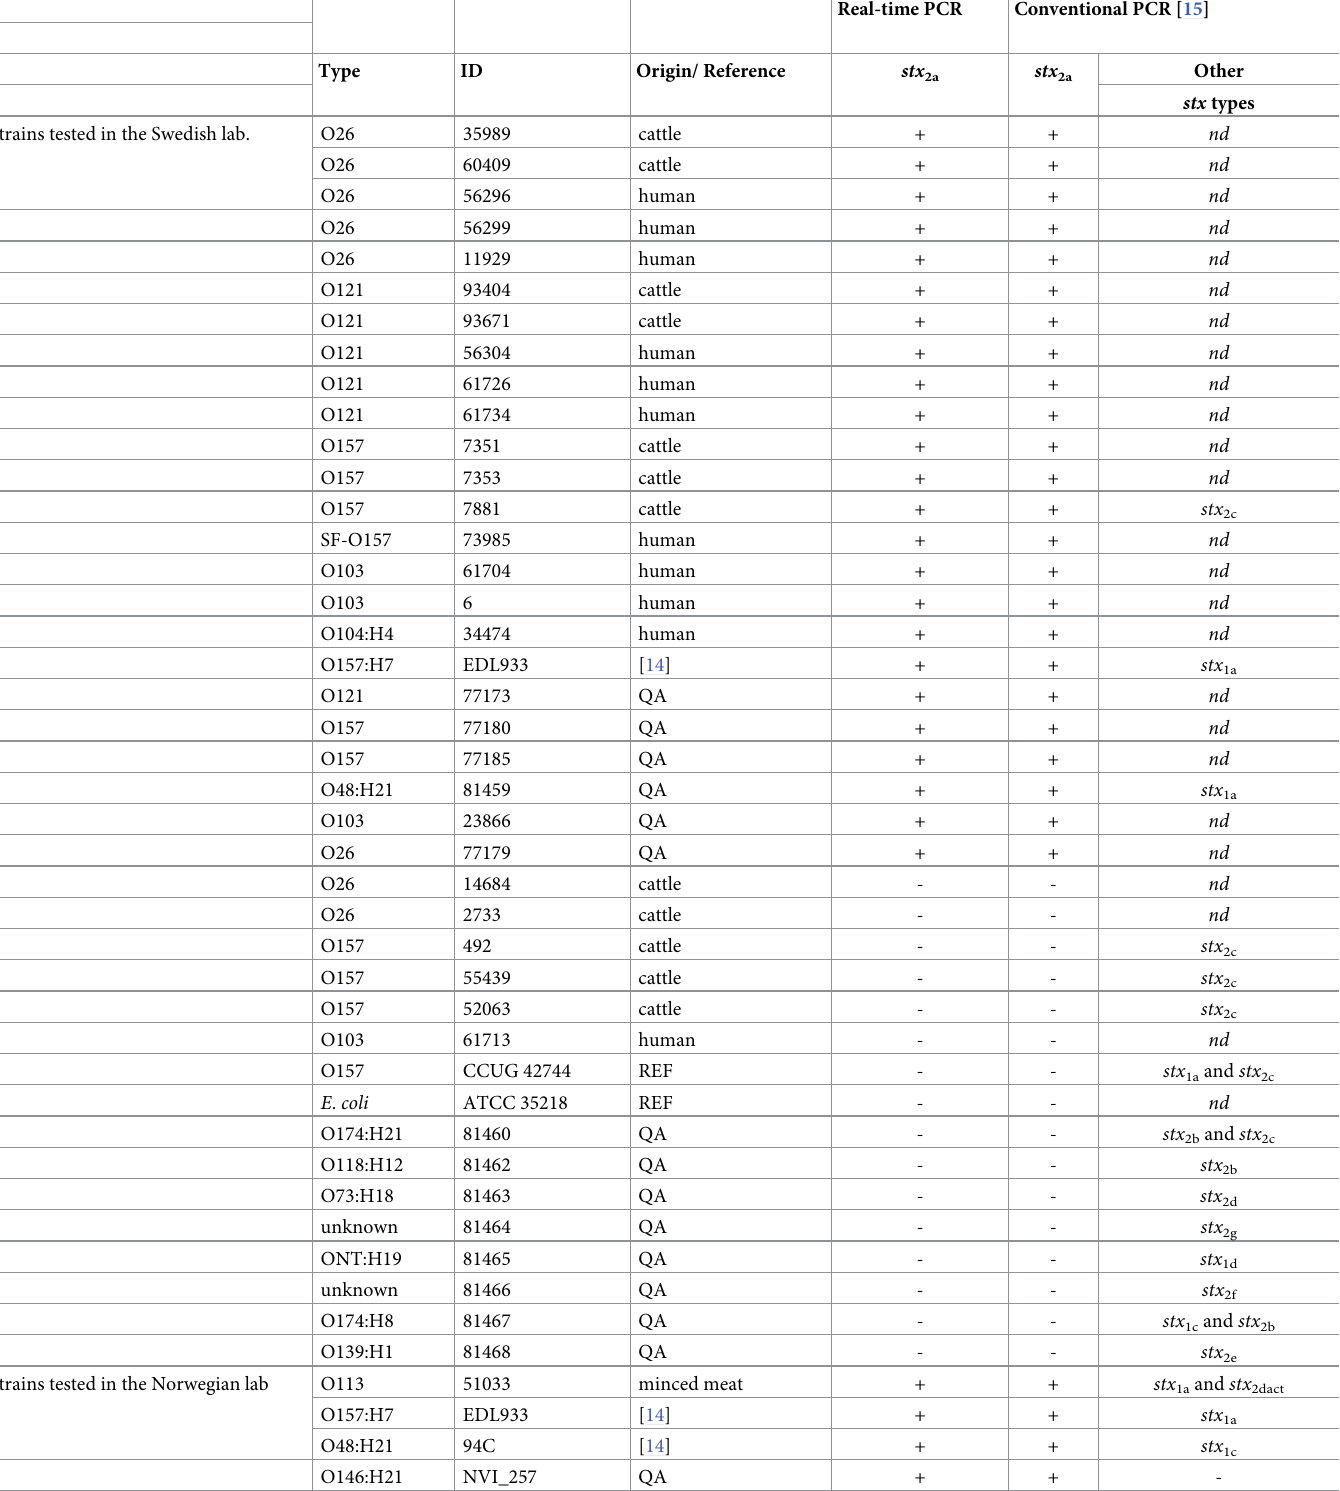
Table 2. Shiga toxin-producing Escherichia coli strains and other E . coli variants for exclusion and inclusion criteria using an stx 2a -specific real-time PCR. Real-time PCR Conventional PCR [15] Type ID Origin/ Reference stx 2a stx 2a Other stx types Strains tested in the Swedish